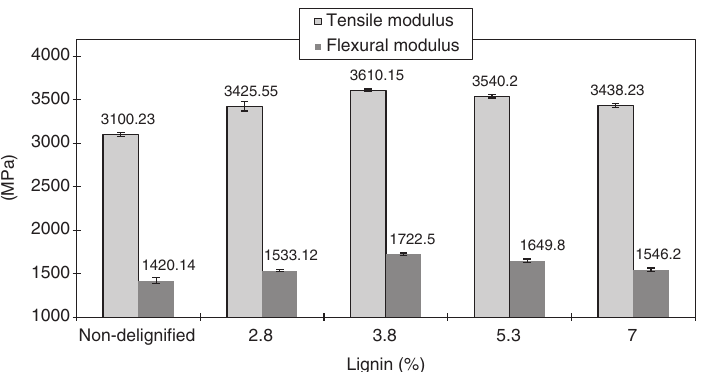
Figure 3: Influence of OCC fiber characteristics on the tensile and flexural modulus of elasticity of OCC fiber/polypropylene composites.